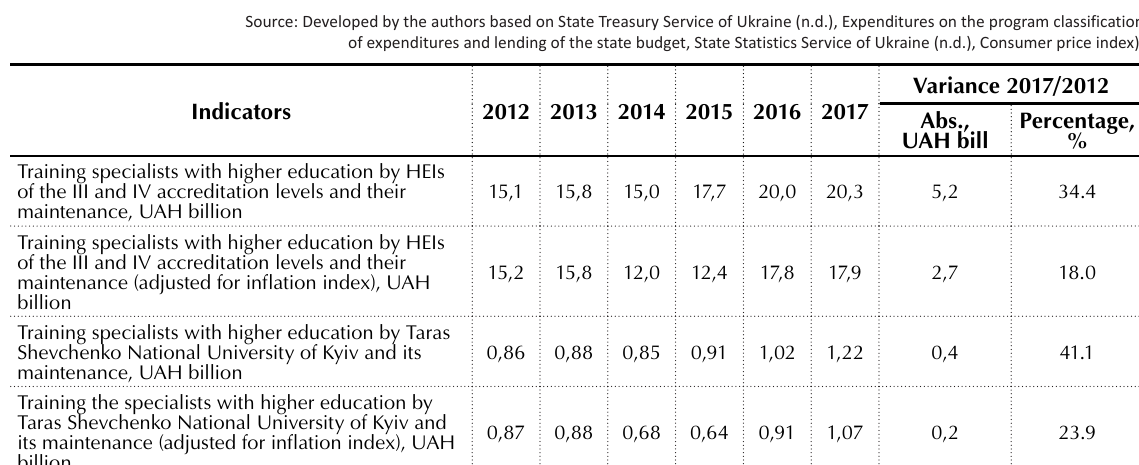
Table 1. The dynamics of budget expenditures on higher education in the period 2012–2017